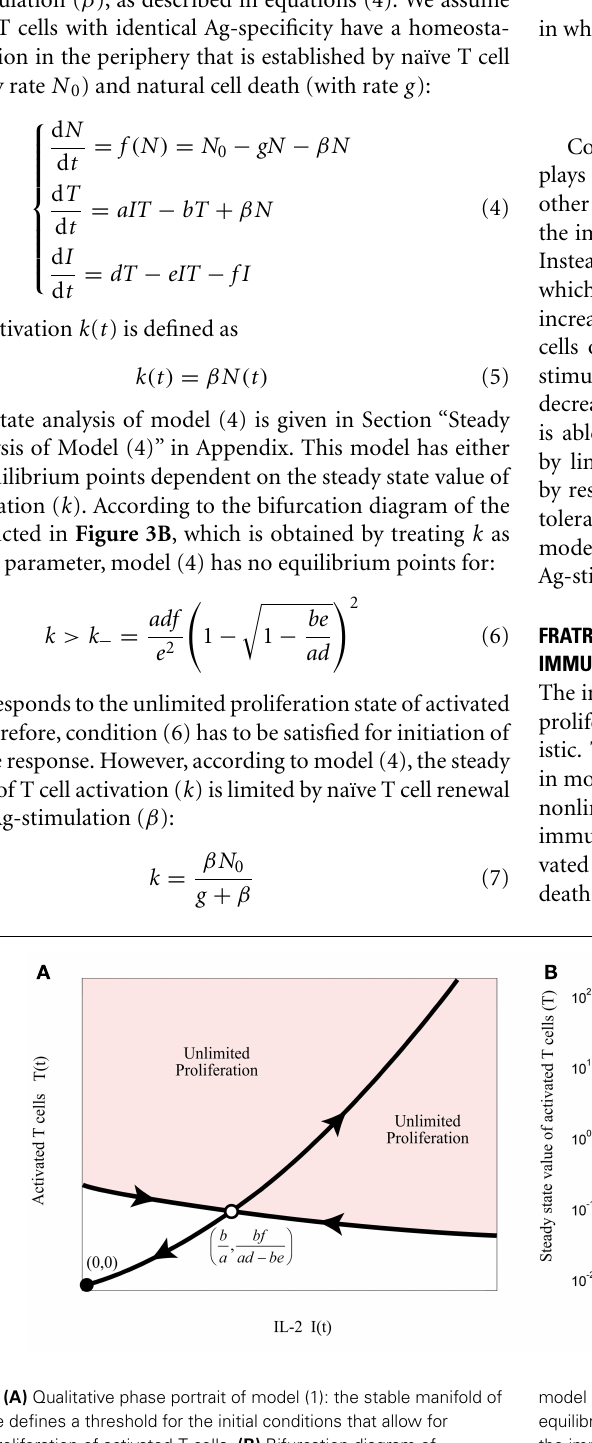
model (4) by treating k as bifurcation parameter. Stable and unstable equilibrium points are shown by black and red lines, respectively. For k > k − , the immune response enters the regime of unlimited